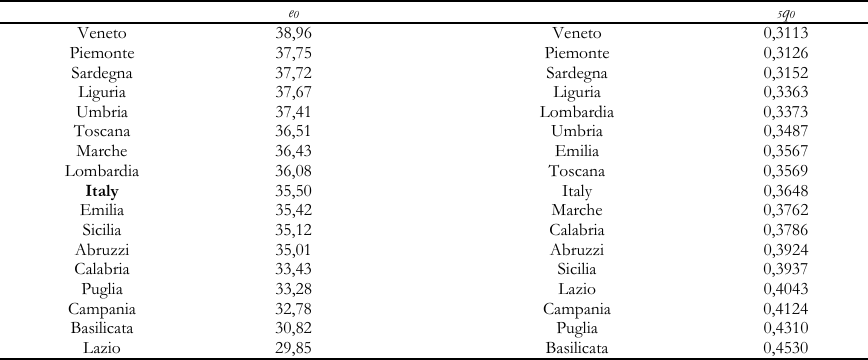
Distribution of Italian regions according to the values of e 0 and 5 q 0 drawn from 1881-82 life table (both